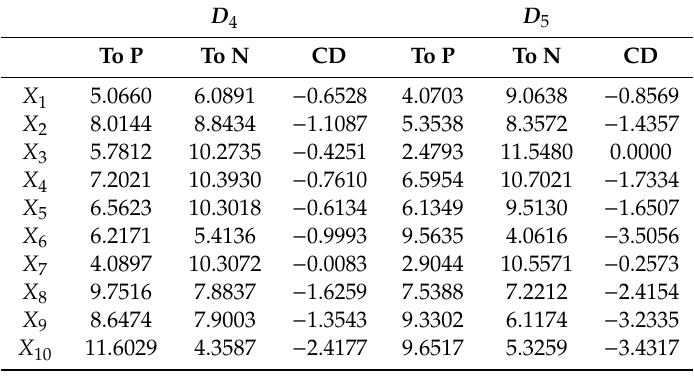
, NSF i ) , MMED ( SF k , PSF i ) and z k ( X i ) for D 4 , D 5 based on UML-TOPSIS-EW. i i